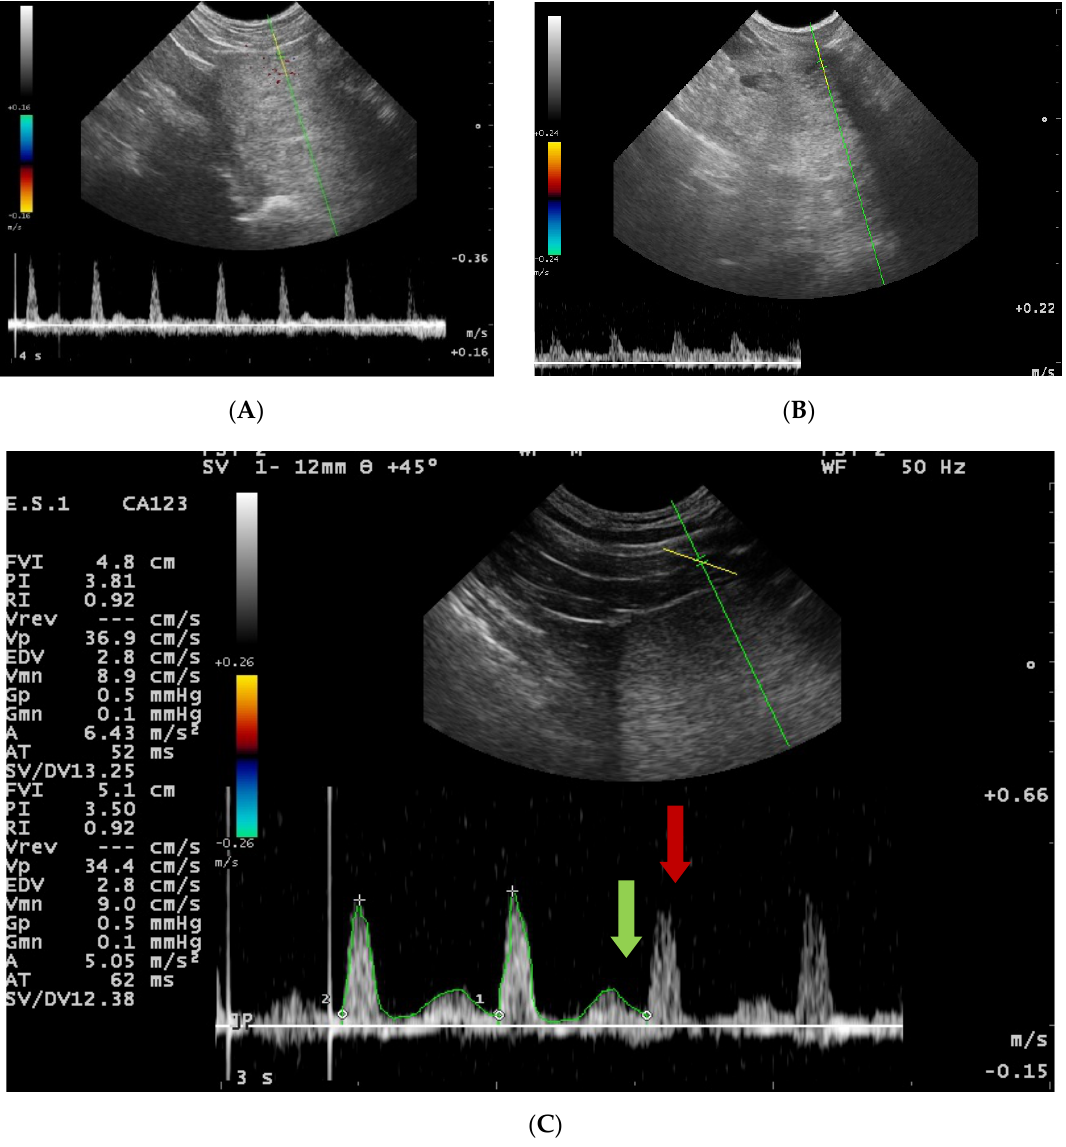
Figure 4. Blood flow patterns, using the duplex technique, of the prostatic artery. ( A )—normal pattern in lateral approach; ( B )—normal pattern in subcapsular approach; ( C )—blood flow pattern in BPH, the flow towards probe, waveform manually traced; red arrow—systolic peak velocity, parabolic flow profile, no spectral window visible and the diastolic peak without flow reversal, a wave with a higher flow velocity visible in diastole —green arrow.